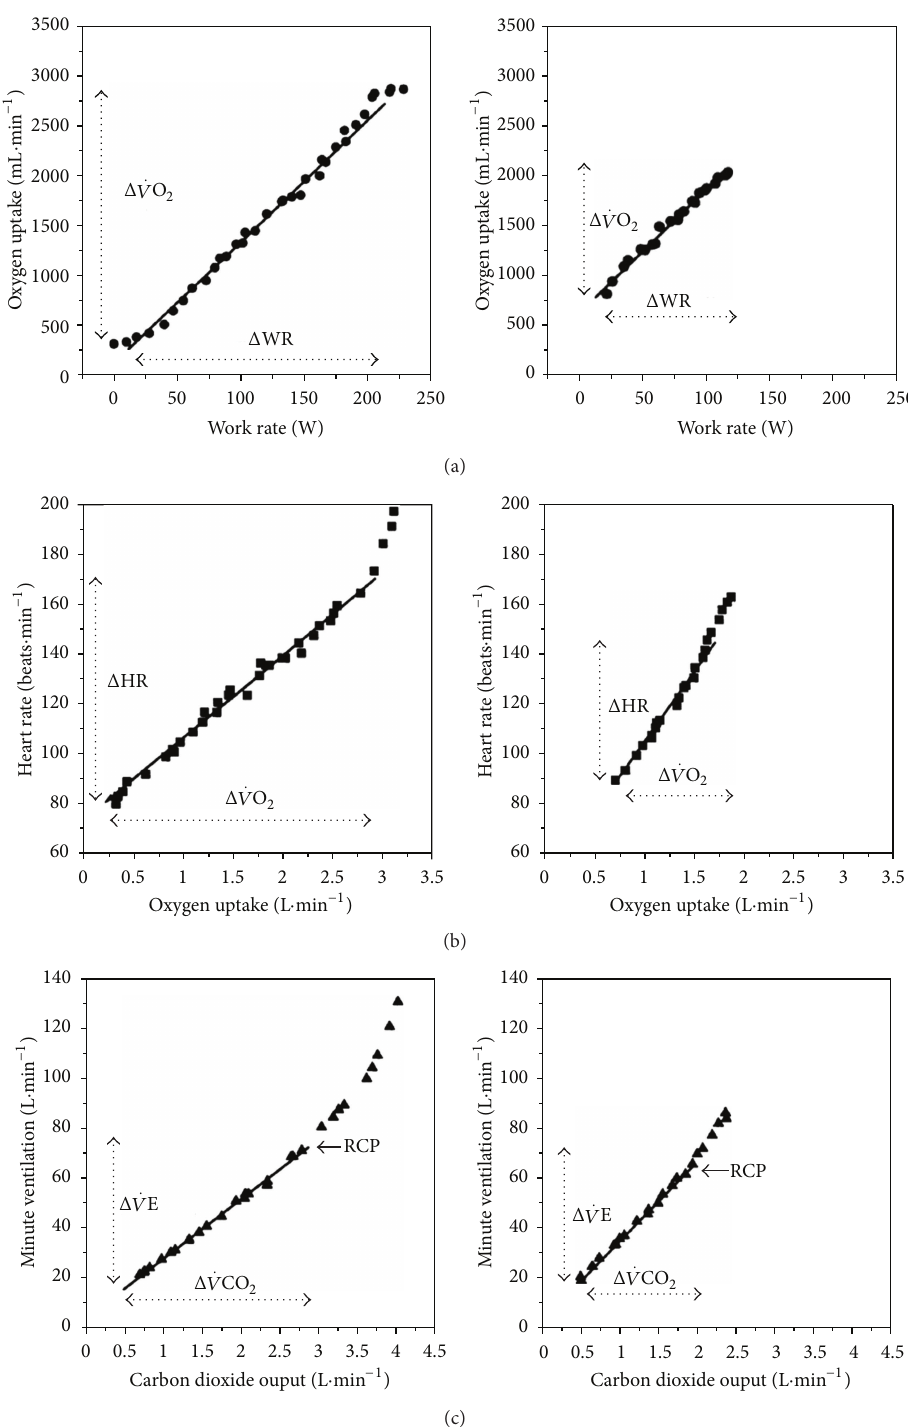
Figure 2: Procedures to establish 3 dynamic submaximal relationships by simple linear regression during incremental CPET in young (24- ̇𝑉 )/Δ work rate (WR); (b) Δ heart rate /Δ ̇𝑉 yr-old, left panels) and old (70-yr-old, right panels) subjects. (a) Δ oxygen uptake ( O 2 ̇𝑉 )/Δ carbon dioxide output ( ̇𝑉 ) . The arrows show the range of values considered for analysis. RCP is the respiratory minute ventilation ( E CO 2 compensation point. (Modified with permission from